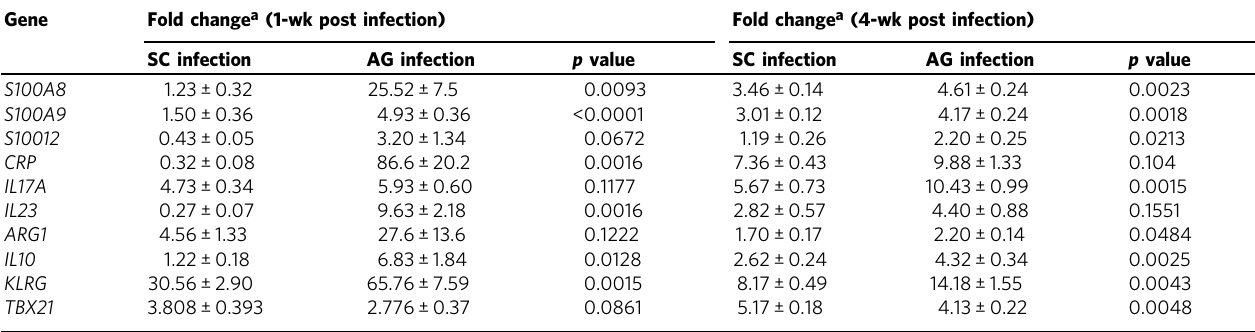
Table 3 Expression level of host in fl ammatory response genes in rabbit lungs infected with Mtb-AG or Mtb-SC. Gene Fold change a (1-wk post infection) Fold change a (4-wk post